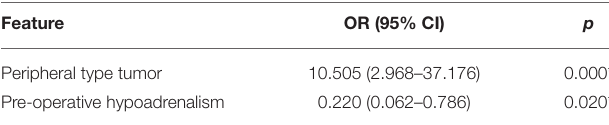
TABLE 5 | Multivariable logistic regression analysis of factors related to pituitary stalk preservation.